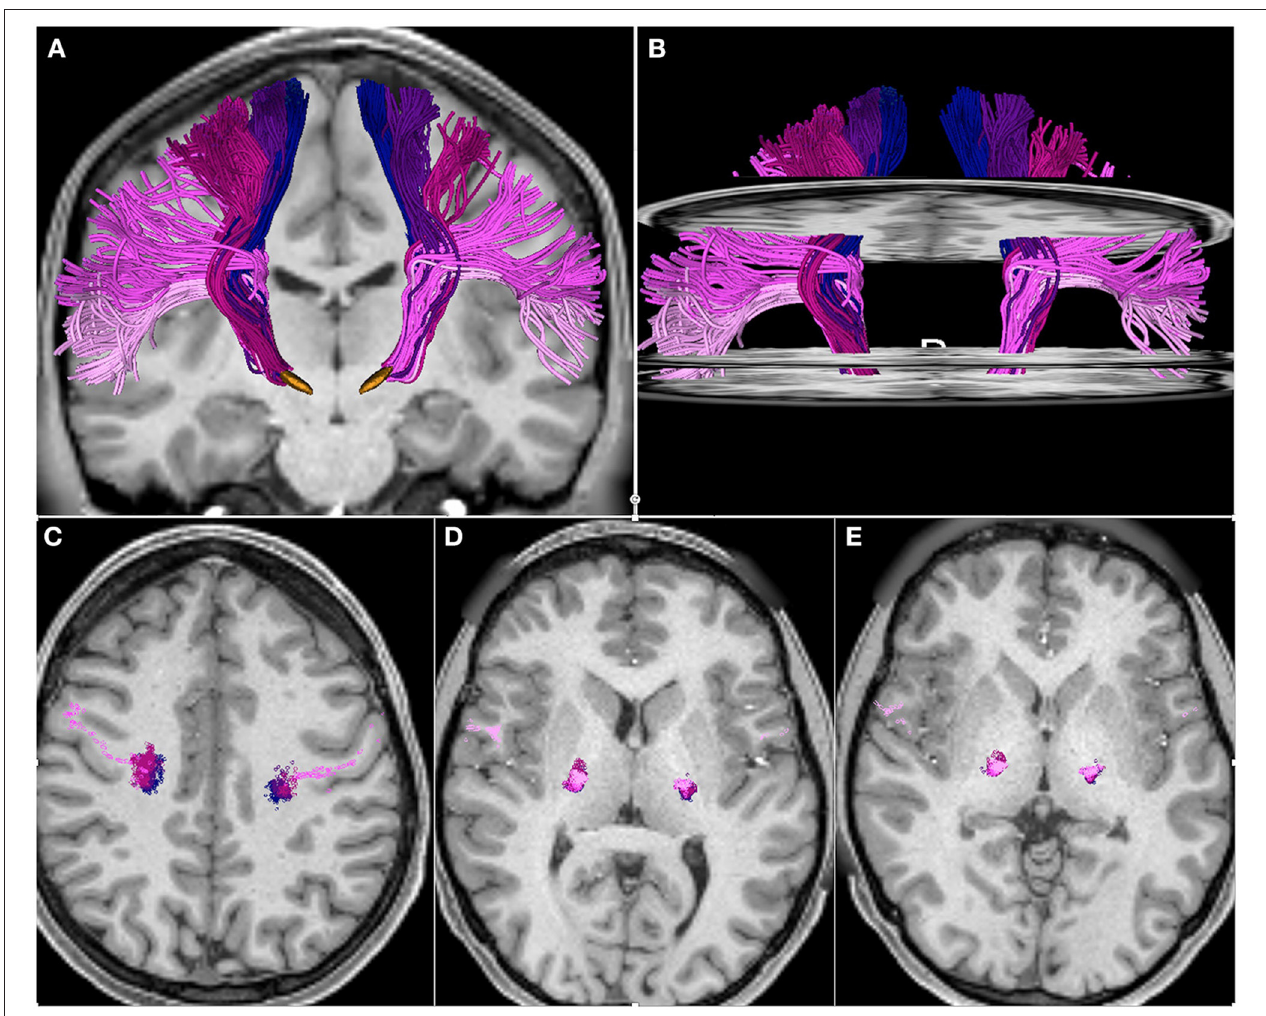
FIGURE 2 | Somatotopic organization of hyperdirect pathway fibers projecting from the primary motor cortex trunk, arm, hand, face, and tongue area. The tracts are displayed on axial and coronal T1-weighted images. (A) 3D anterior view of hyperdirect pathway fibers with 3D models of the subthalamic nucleus (orange). (B) 3D anterior view of hyperdirect pathway fibers with axial T1-weighted images at the level of the coronal radiata, internal capsule and zona incerta. (C–E) Intersection of hyperdirect pathway fibers with an axial T1-weighted image at the level of the corona radiata (C) , posterior limb of the internal capsule (D) , and zona incerta (E) . The three axial slices in (B) correspond to the axial images displayed in (C–E) . The fibers are colored according to the motor regions: trunk (blue), arm (dark purple), hand (dark pink), face (light purple), tongue (light